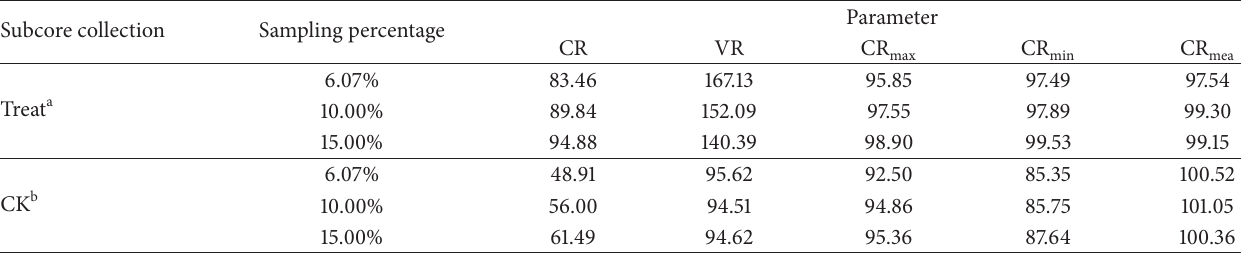
Table 3: The values of five evaluating parameters in subcore collections constructed by three sampling percentages with 20 traits.